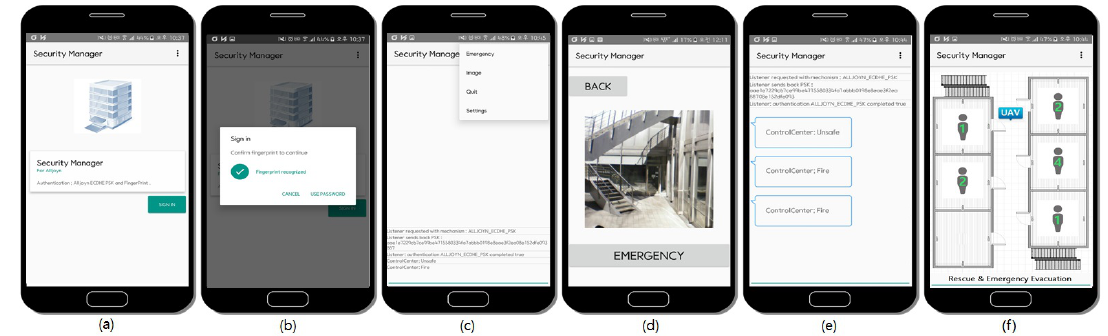
Figure 8. The interface of the building Security Manager app.( a ) first page of security manager app , ( b ) fingerprint authentication process, ( c ) security manager app in a normal situation, ( d ) an abnormal temperature is detected, ( e ) security manager app in abnormal situation, ( f ) rescue and emergency evacuation mode of security manager